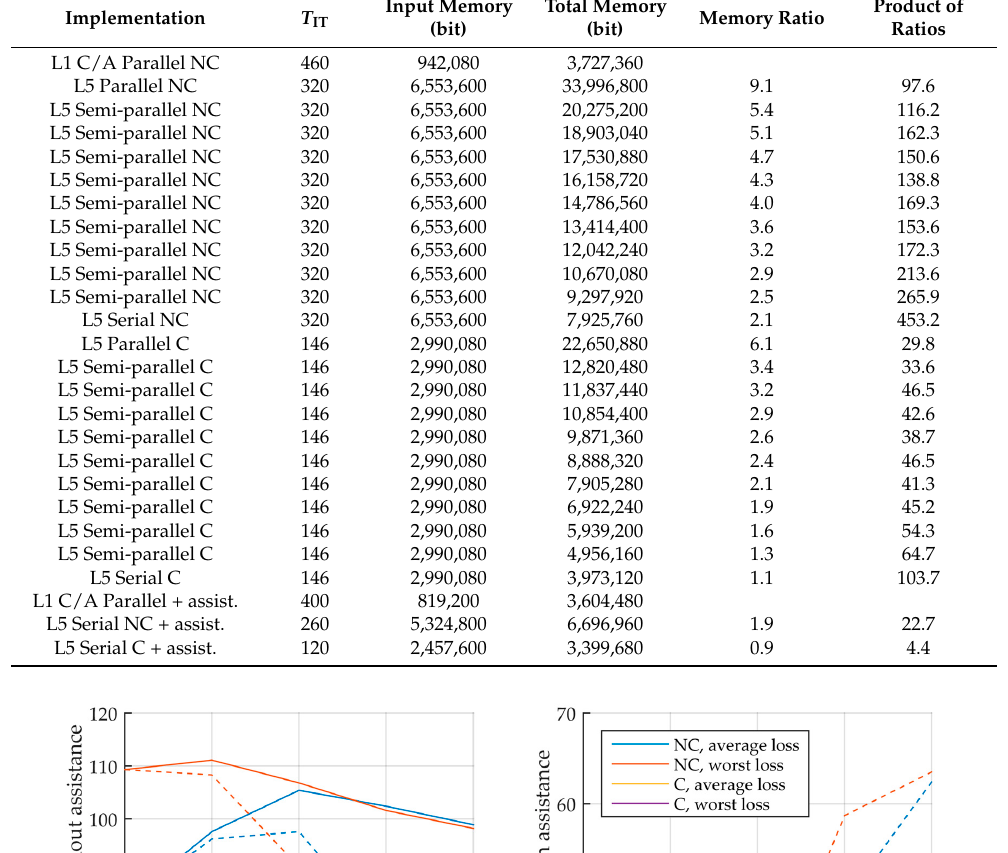
Table 9. Memory requirements (bit) of the different implementations for a sensitivity of − 150 dBm with average losses, considering the input memory. Ratios are computed with the values of the L1 C/A signal.